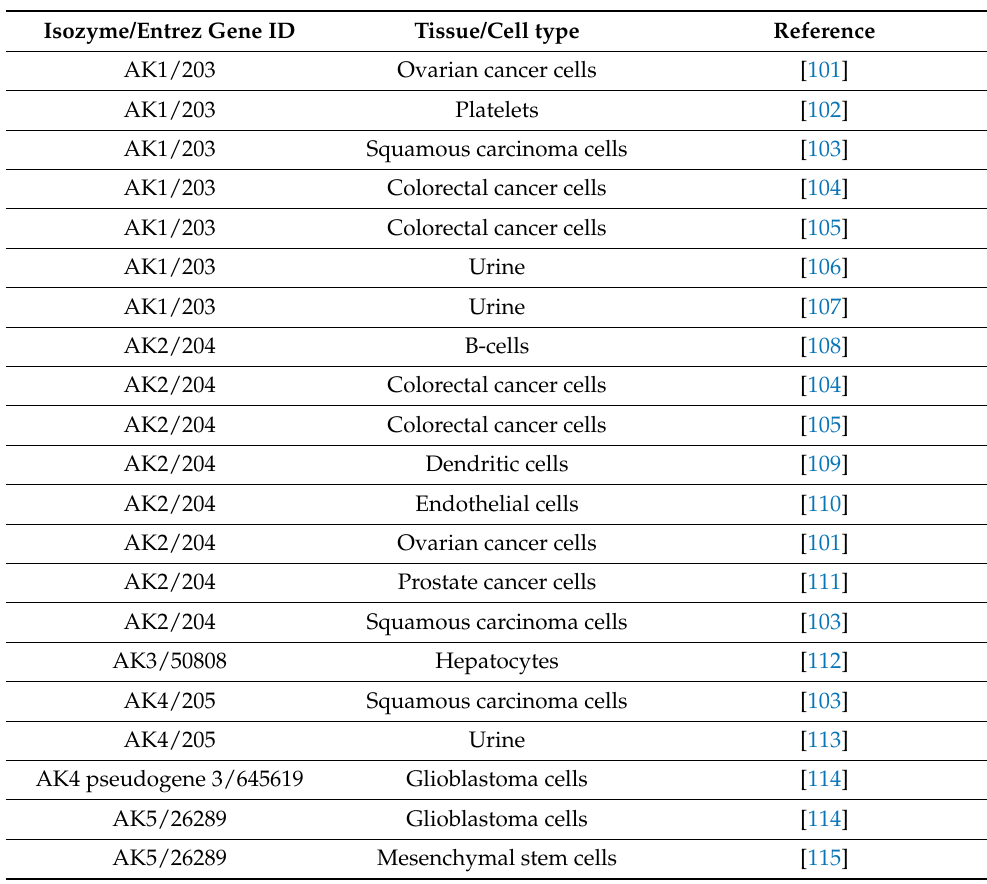
Table 2. AK isozymes in